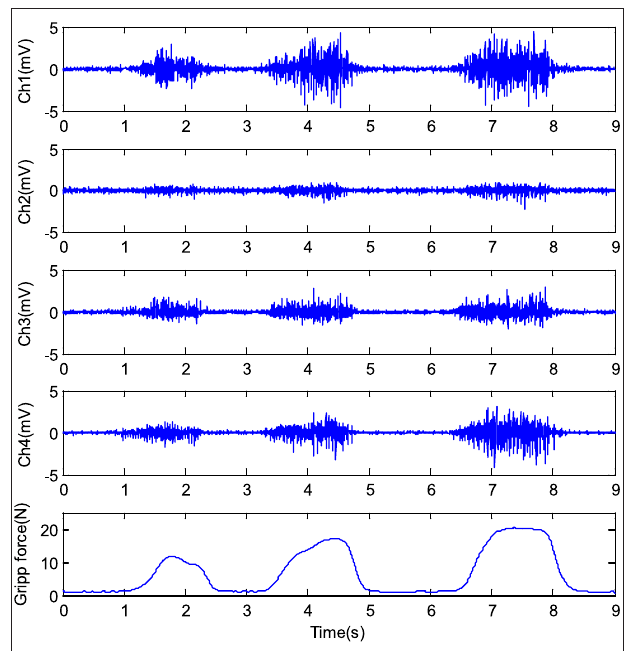
FIGURE 13 | The EMG signals and the corresponding grip